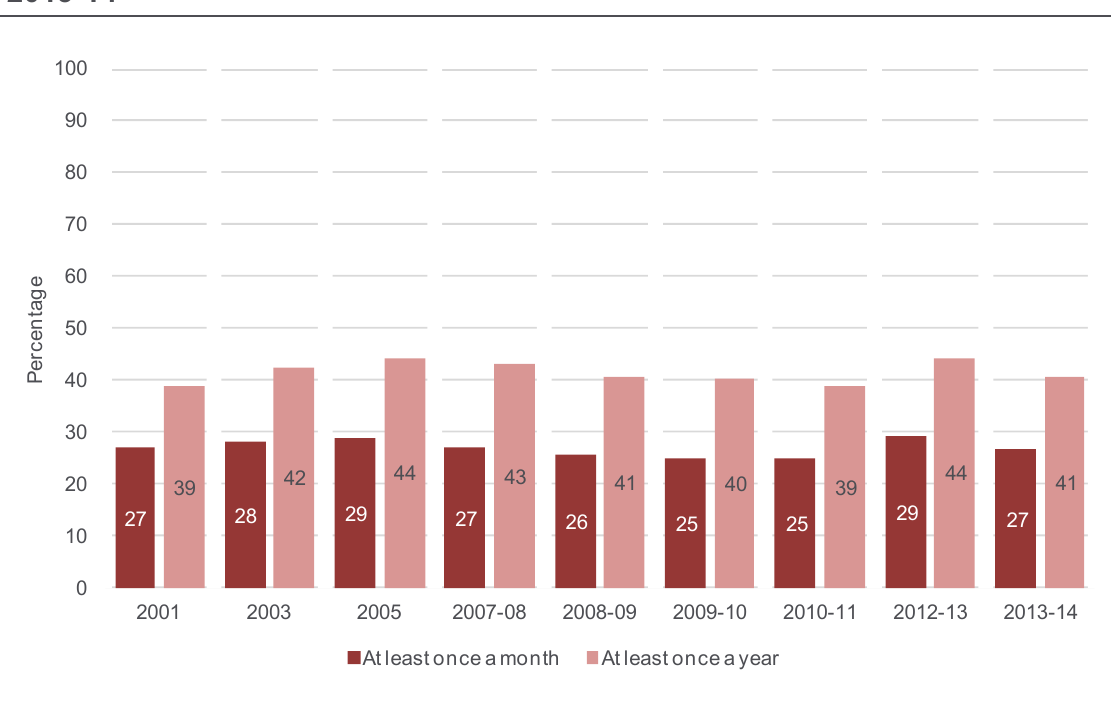
Table 1: Participation in civic engagement and voluntary activities, 2001 to 2013-14